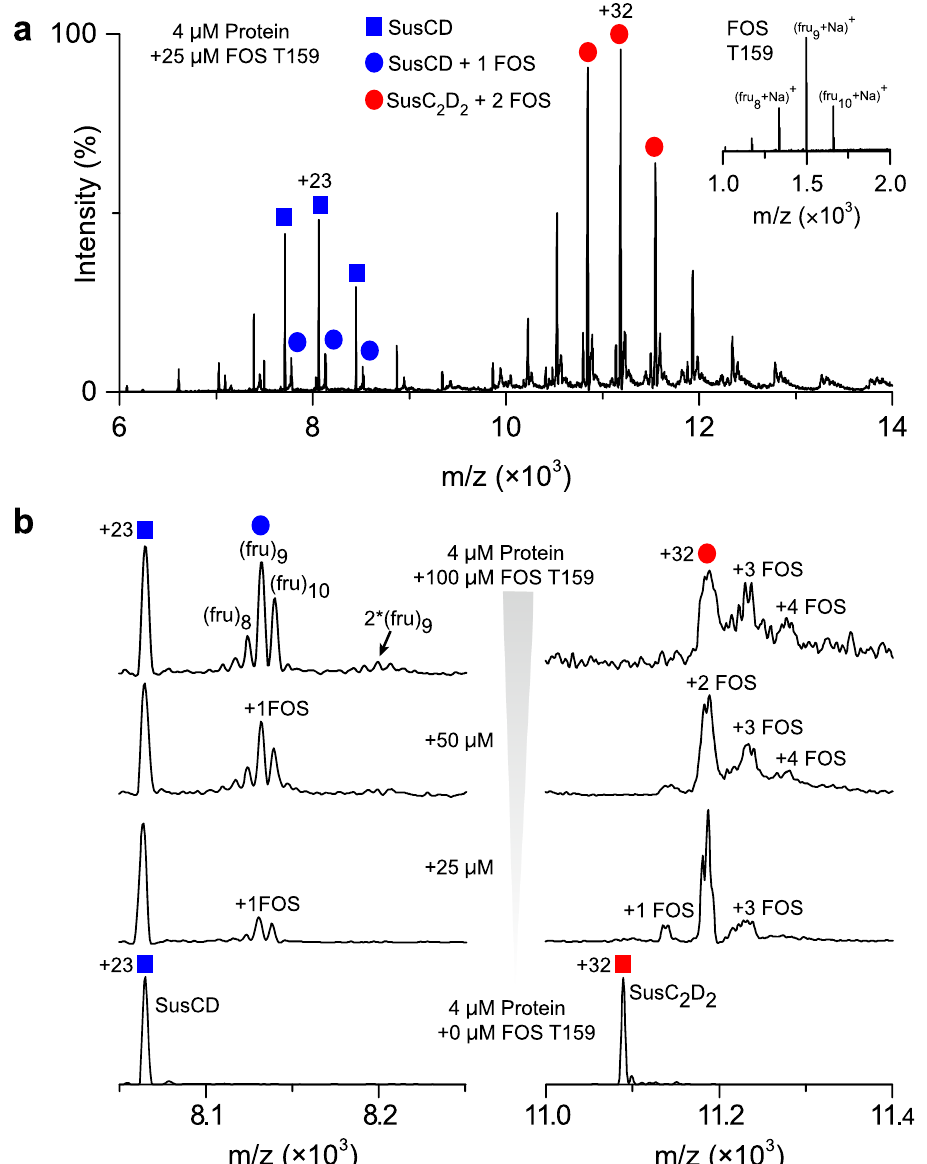
Fig. 7 Bt1762-63 binding to medium-chain fructo-oligosaccharide (FOS). a Native mass spectrum of Bt1762-63 bound to FOS T159 fraction (~DP9) revealed the presence of both bound and unbound SusCD monomers, but only FOS-bound SusC 2 D 2 dimers. The inset shows the spectrum of the FOS T159 fraction. b Spectrum of Bt1762-63 incubated with different concentrations of FOS T159. Shown are individual charge states of the monomer ( + 23) and of the dimer ( + 32). Up to two and four FOS molecules (mainly 8 – 10 fructose units) were found to bind to SusCD and SusC 2 D 2 , respectively. Masses of all species observed are listed in Supplementary Table